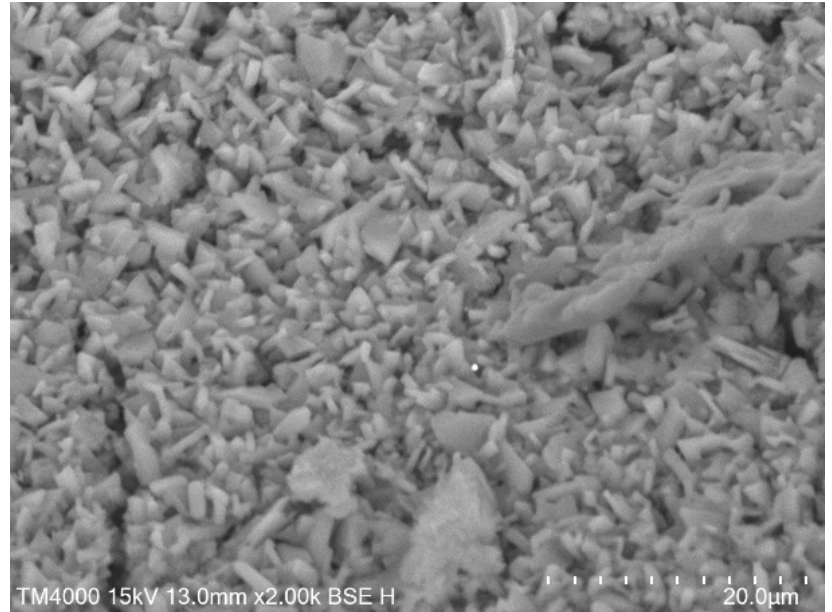
Figure 16. SEM micrographs of MPC without BA at 28 days.